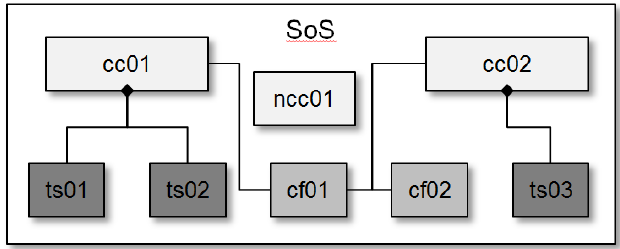
Figure 3. Architecture with connection (e.g. cc01 − cf01 ) and containment (e.g. cc01 − ts01 ) relations.